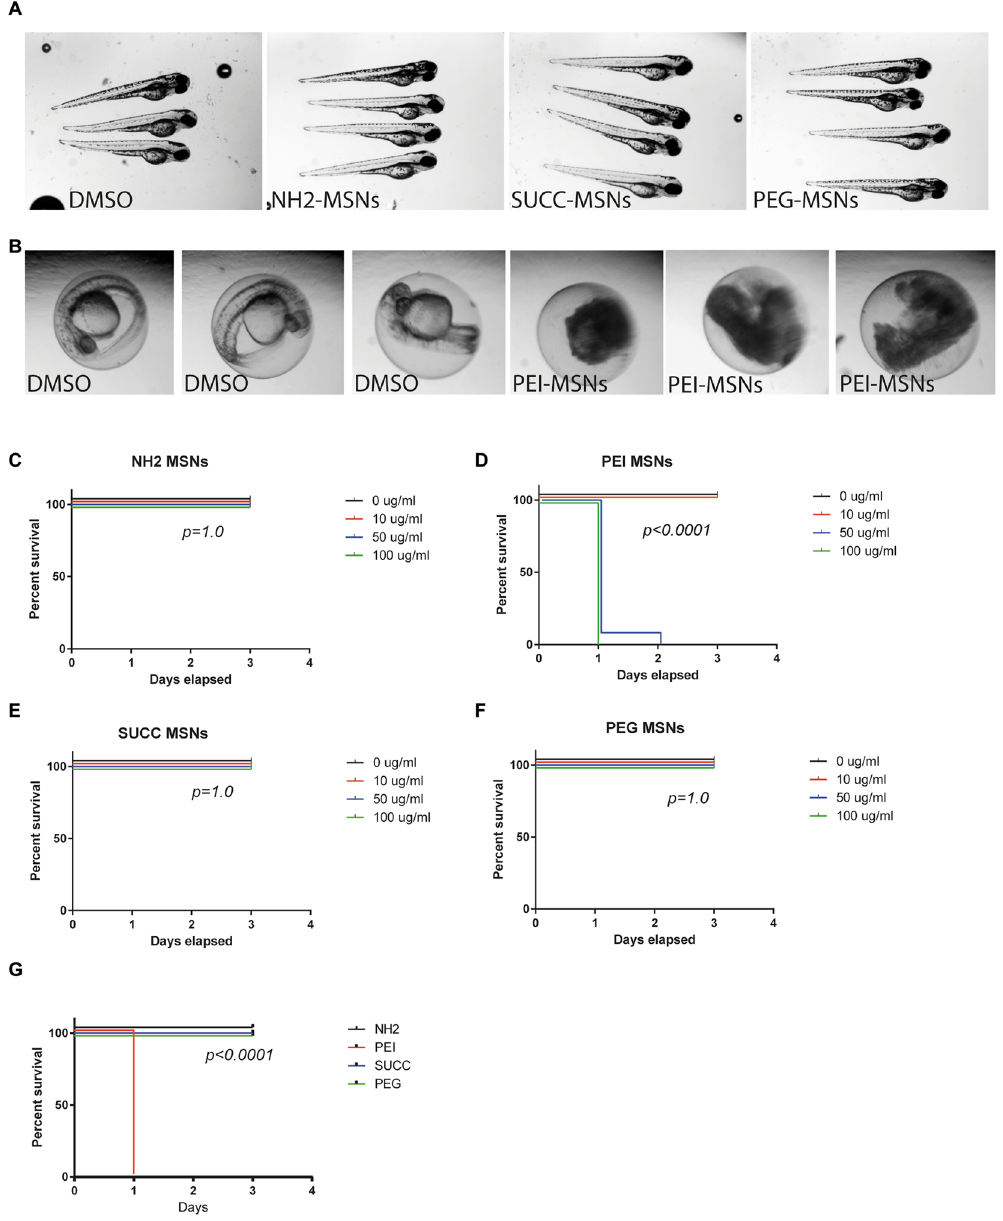
Figure 2. Surface functionalization affects overall toxicity of MSNs. ( A ) Zebrafish embryos at 72 hpf treated with the DMSO vehicle, NH2-, SUCC- and PEG-MSNs at a concentration of 50 μ /ml. Treatment was initiated at 8hpf. The embryos are anesthesized and mounted in 2%methyl cellulose. ( B ) Zebrafish embryos at 48 hpf treated the DMSO vehicle or 50 μ g/ml PEI-MSNs. Treatment was initiated at 8hpf. ( C – F ) Percentage of survival of embryos at 24hpf, 48 hpf and 72hpf upon treatment with ( C ) NH 2 -, ( D ) PEI-, ( E ) SUCC- and ( F ) PEG- MSNs at denoted concentrations. The treatment was initiated at 8hpf. N = 24 embryos/treatment, except in PEI-MSN 10 μ g/ml (n = 25) and SUCC-MSN 100 μ g/ml (n = 25). Each embryo was followed throughout the experiment and score live or dead on each day ( G ) Comparison of survival between nanoparticles at 100 μ g/ml